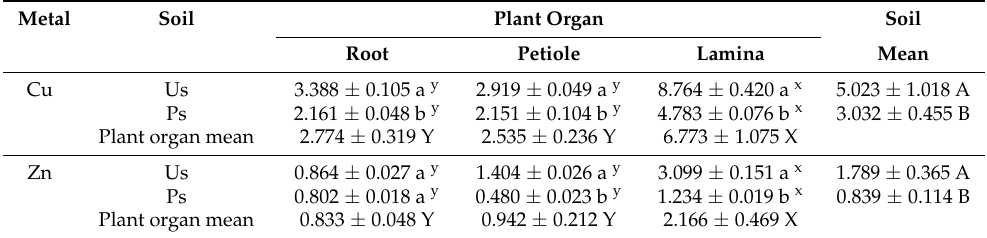
Table 7. BAF of Cu and Zn in different organs of S. perfoliatum plants grown in heavy metal Ps and